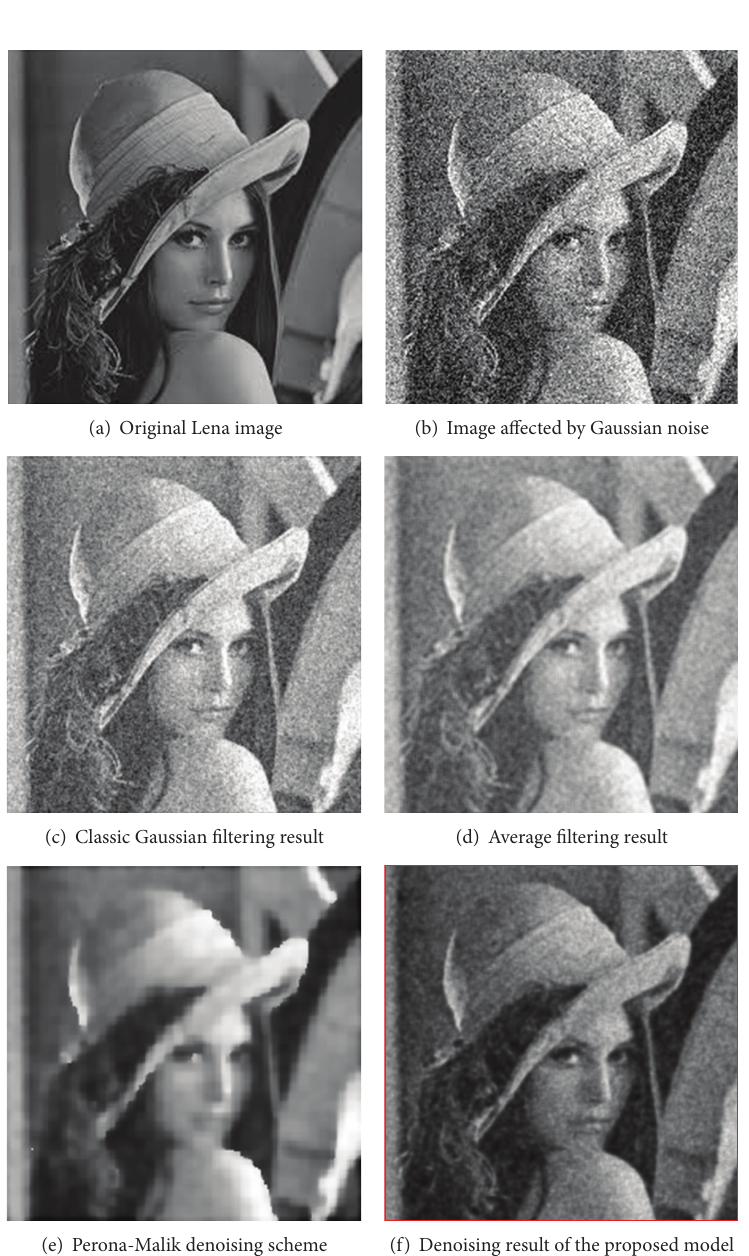
Figure 1: Gaussian noise removal results produced by our technique and other approaches.